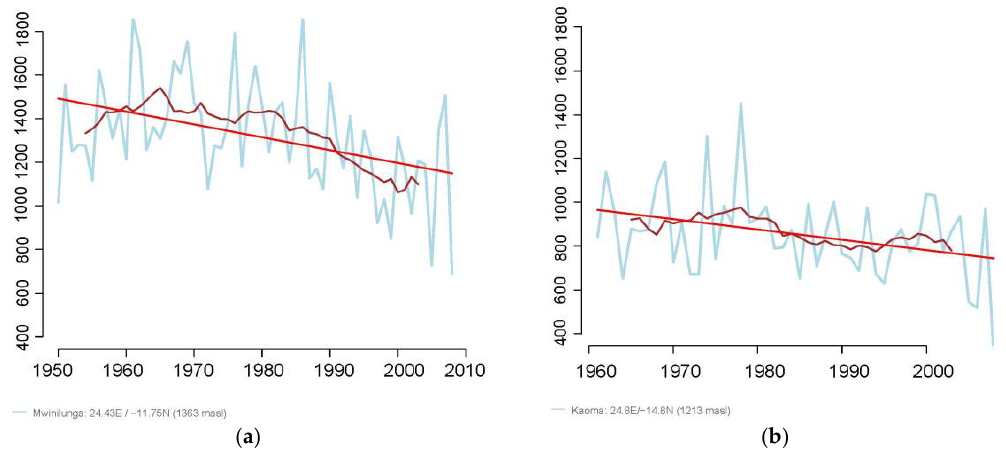
Figure 7. Observed trends (1950–2010) in annual rainfall at two of the climate stations within the Zambezi Basin, Mwinilunga ( a ) and Kaoma ( b ). The y–axis is the annual rainfall in mm. The brown line represents the 5-years moving average while the red line is the simple linear trend line.